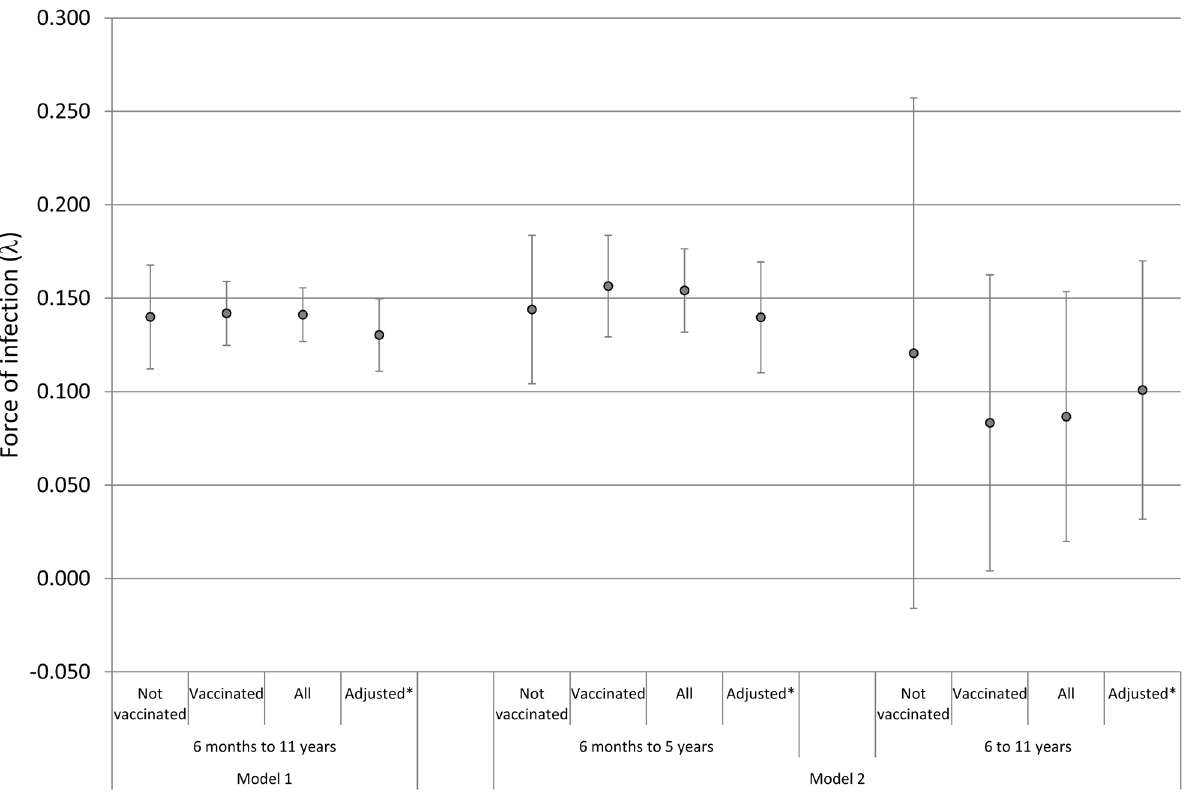
Figure 2. Force of dengue infection estimates and 95% CIs by JE vaccination status. Model 1: constant force of infection; Model 2: different forces of infection above and below 6 years. Figure 2 footnote: * Estimates from a model adjusting for JE vaccination status.